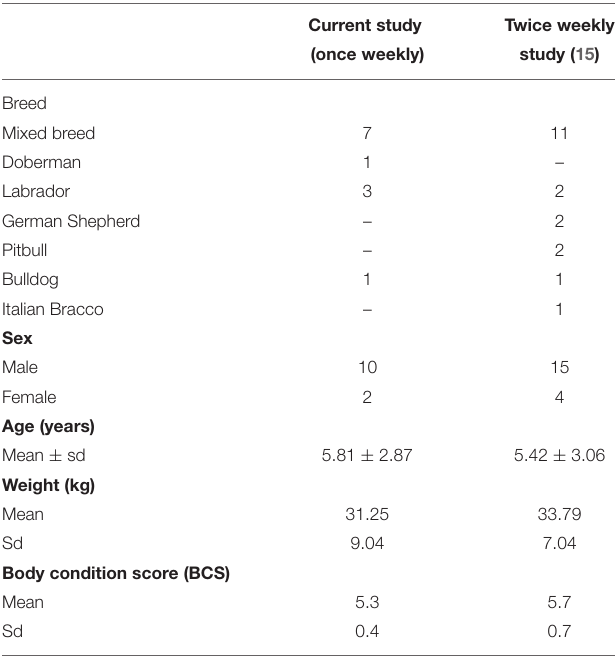
TABLE 1 | Signalment data of